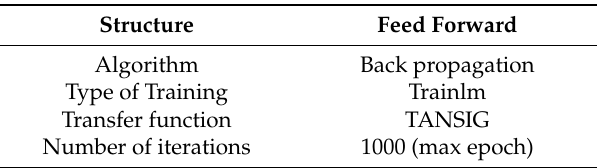
Table 7. Parameters for developing ANN Model.